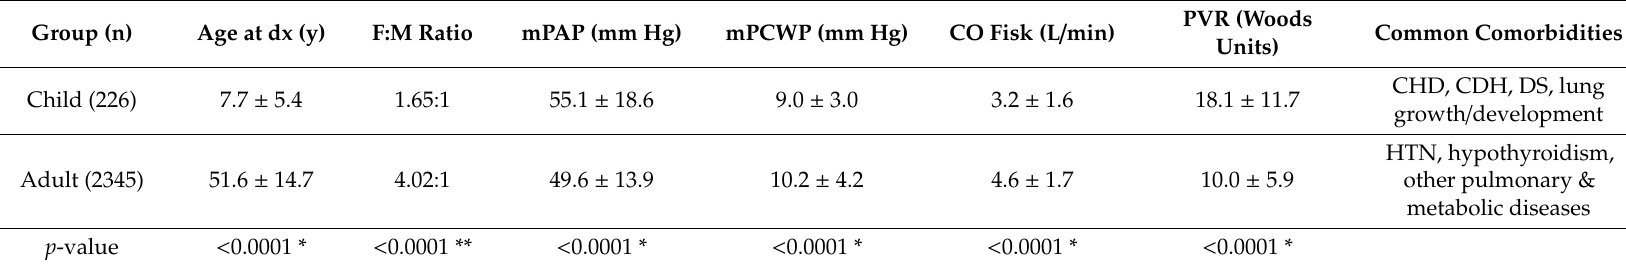
Table 1. Clinical characteristics and hemodynamic parameters of child- vs. adult-onset pulmonary arterial hypertension (PAH) cases at diagnosis. Data are from the PAH Biobank ( n = 2572). Child-onset, < 18 years of age at diagnosis. Mean ±